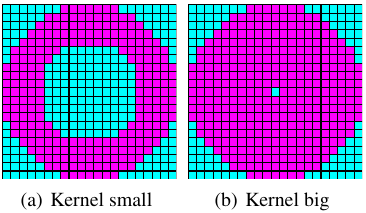
Figure 3: Comparison of different kernel sizes